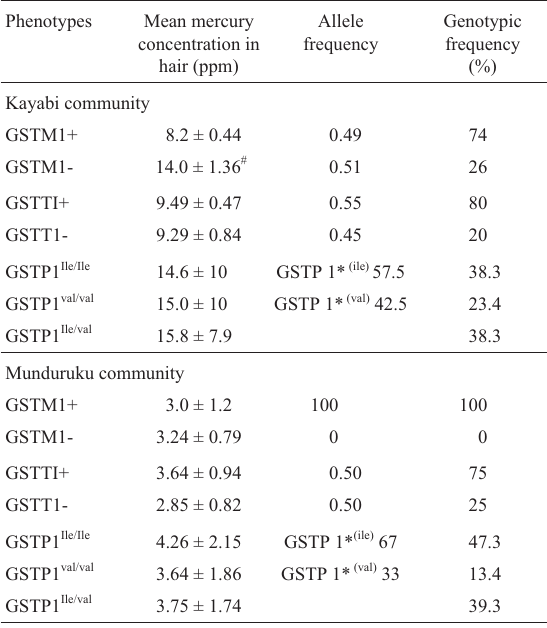
Table 3 - Phenotypes of GST families with its respective allelic and genotypic frequencies and levels of Hg in the Kayabi and Munduruks